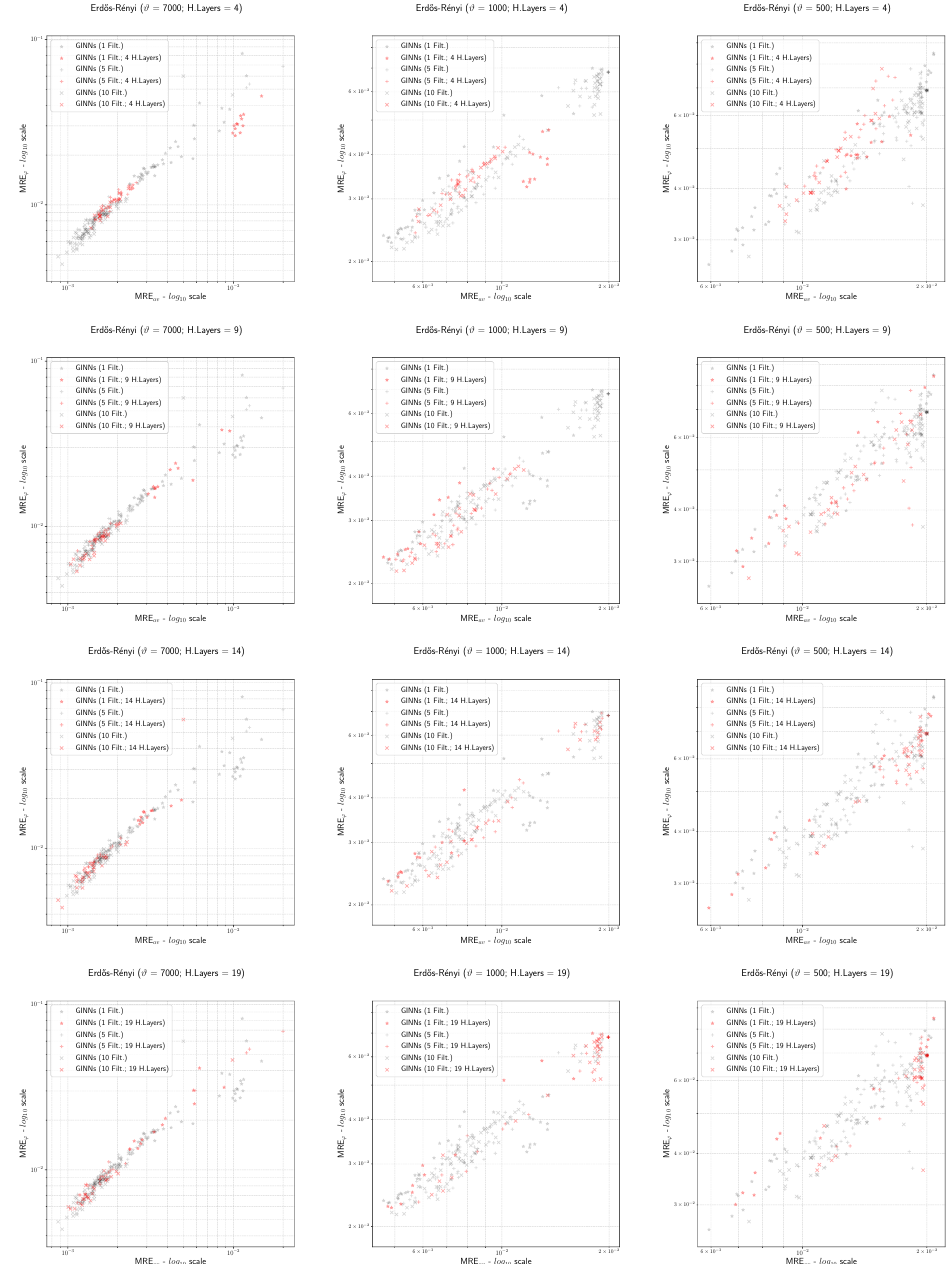
Figure 10. Scatter plots in the ( MRE av ,MRE ϕ ) plane of the GINNs trained with respect to left to right, the GINNs are trained using ϑ = 7000,1000,500 samples; from top to bottom, the red markers highlight the GINNs with hyper-parameters of H = 4,9,14,19 (black markers for all the other